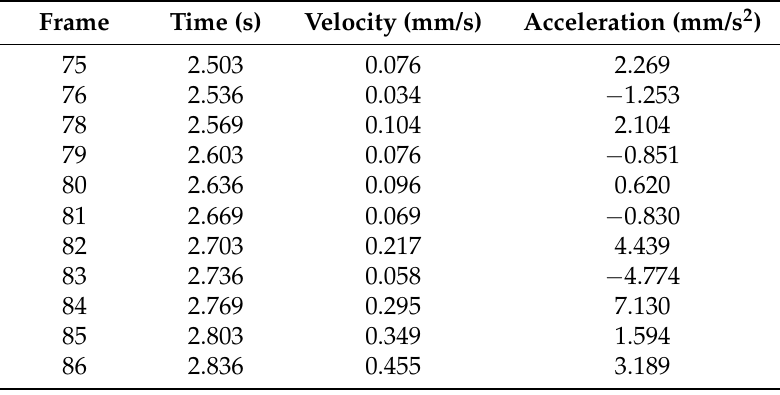
Table 2. Acceleration (mm/s 2 ) of “hatched” miracidium seen in Figure